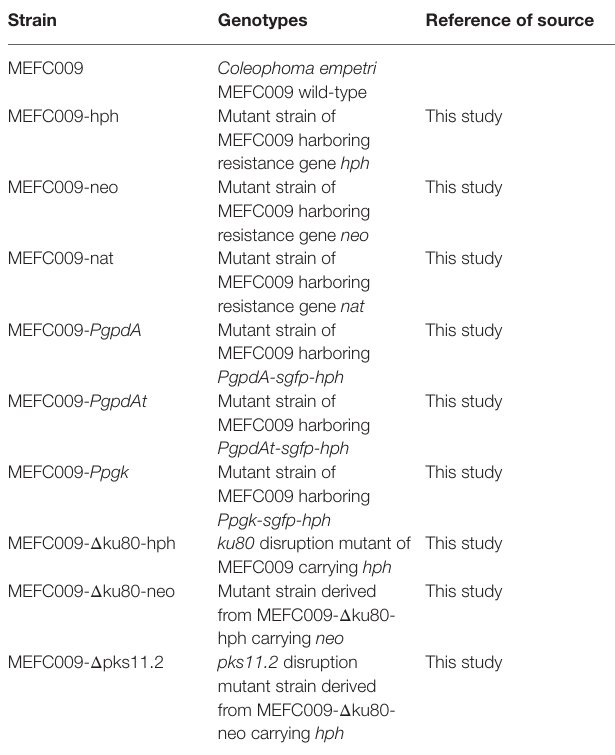
TABLE 1 | C. empetri MEFC009 strains used in this